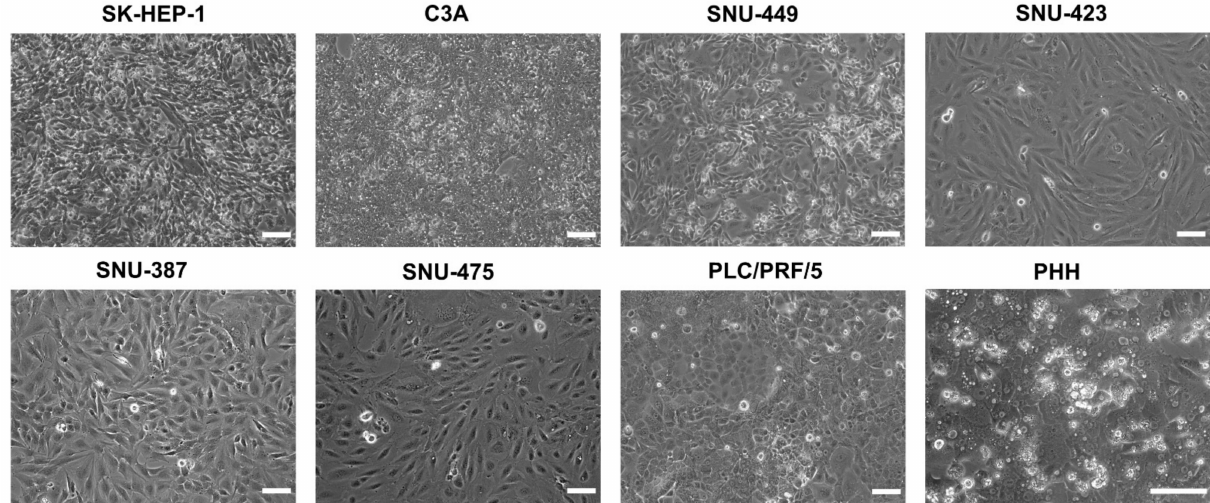
Figure 1. Phase contrast images of liver cancer cell lines and primary human hepatocytes (PHH) at 100% confluence. All assays and extractions were performed when liver cancer cell lines reached 100% confluence. Phase contrast images were taken on a Nikon Eclipse T i -S microscope (Nikon, Tokyo, Japan) with a 10 × (liver cancer cell lines) or 20 × objective (PHH). Scale bar = 100 µ